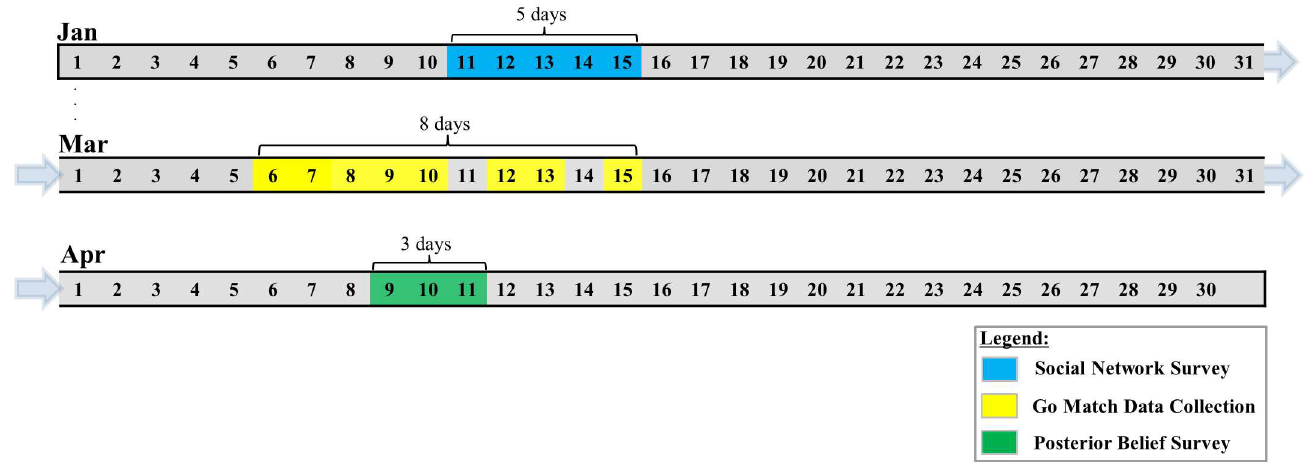
Fig 2. The schedule for three surveys. (A) Social Network Survey—offline (experimentalroom) (B) Go Match Data Collection—online; knowledgeof Go & AI—offline (experimental room) (C) Posterior Belief Survey—offline (take-home); IRI Survey—offline(experimental room)